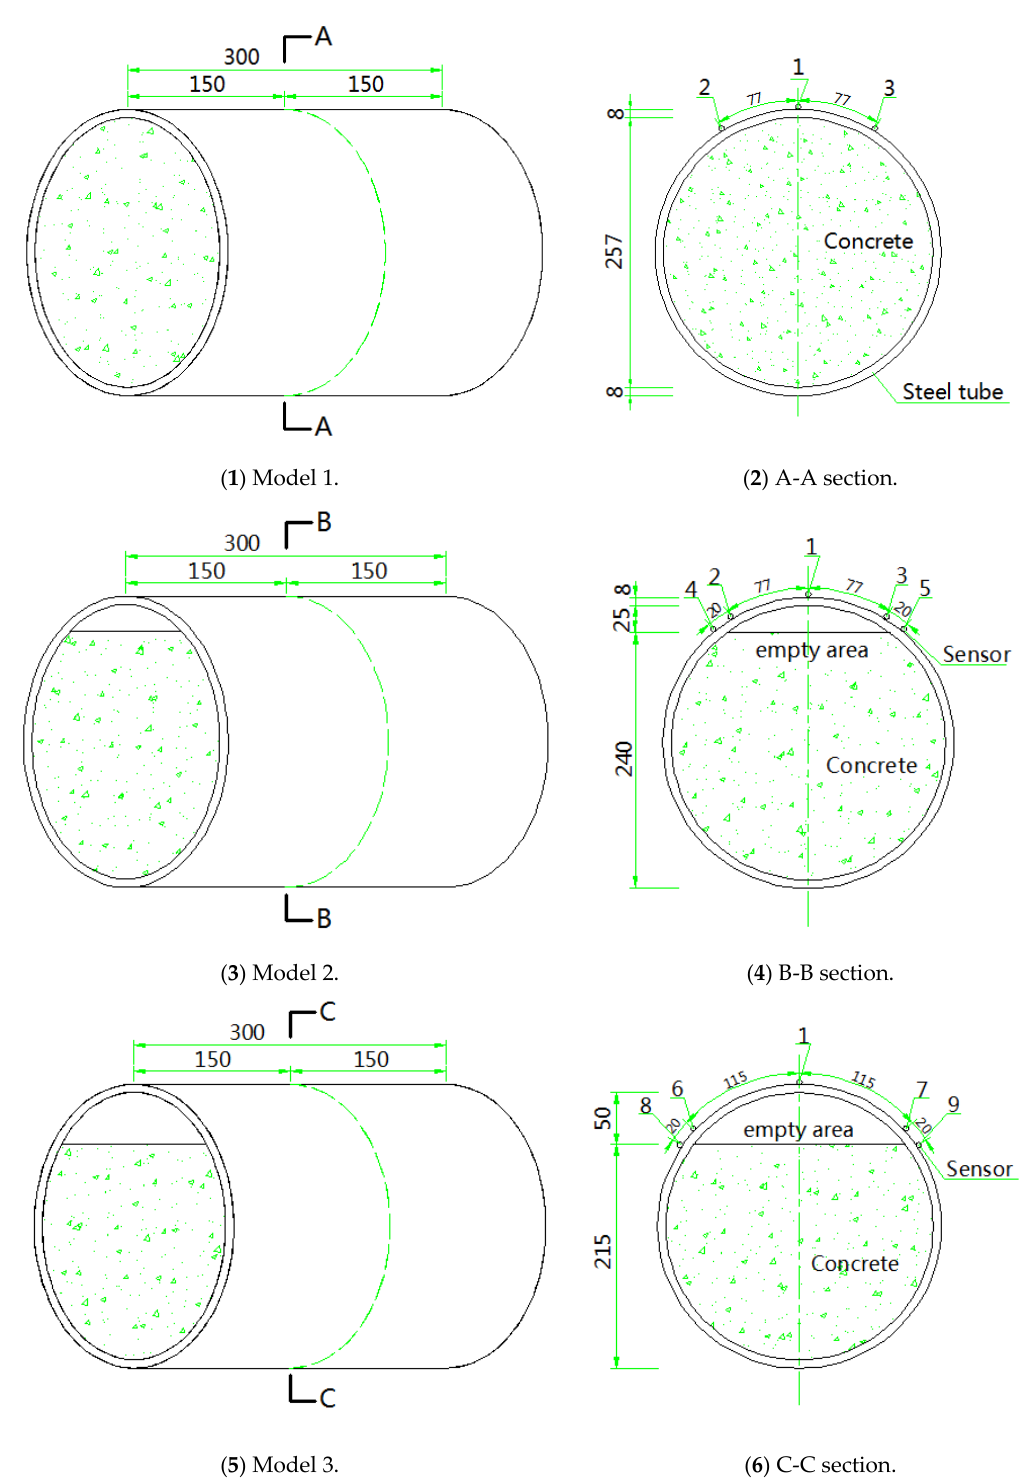
Figure 9. Specimen size and sensor layout.